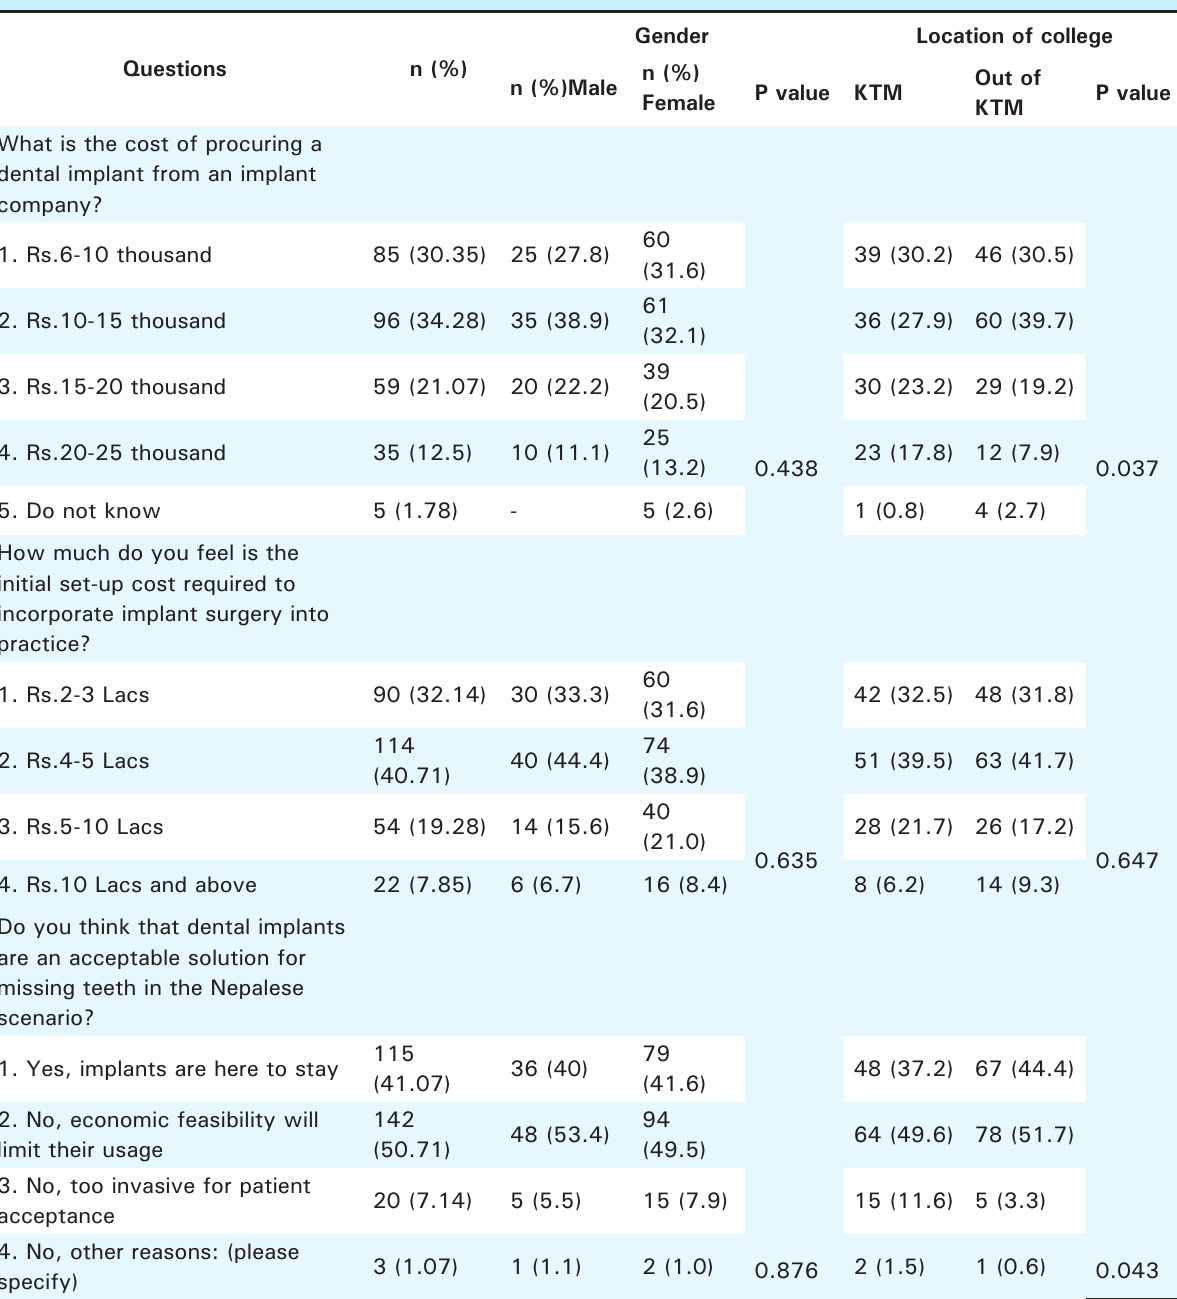
Table 3. Responses to the 7 th , 8 th and 9 th questions and their associations with gender and location of the